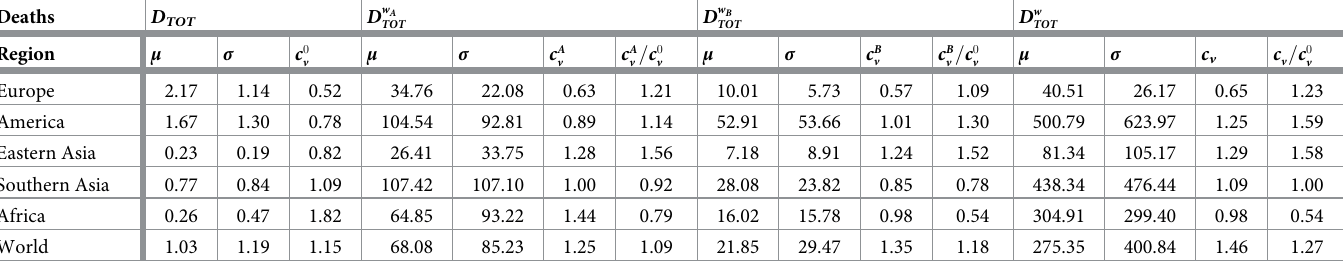
Table 2. Same as Table 1 for D TOT the total number of COVID-19 deaths per thousand inhabitants since the beginning of the